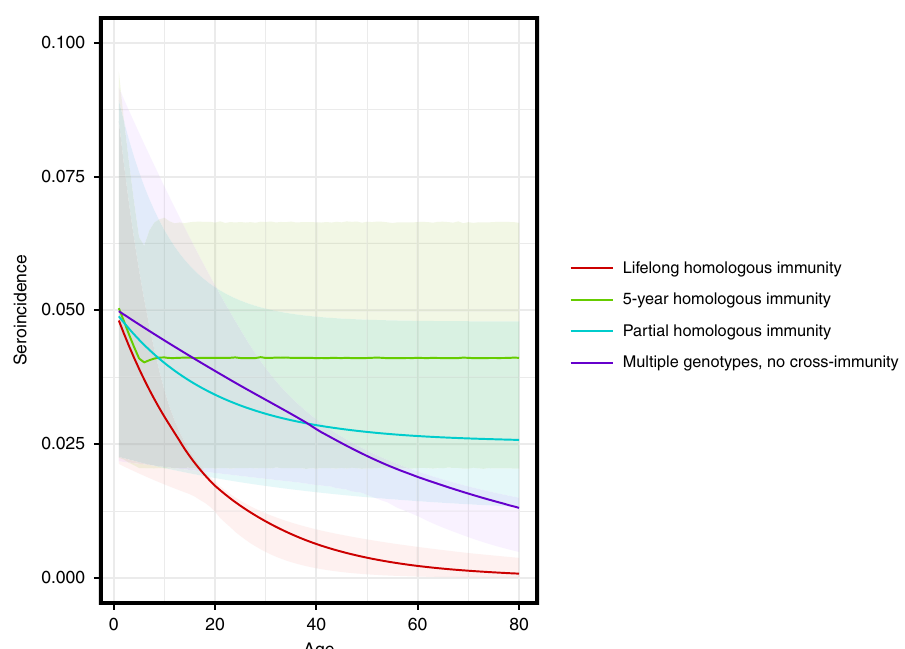
Fig. 7 Age-seroincidence curves under four models of coronavirus immunity. Each curve displays the age seroincidence for a single endemic strain. The four hypothetical models of coronavirus immunity are (1) infection grants lifelong, complete homologous immunity (red), (2) infection grants complete homologous immunity for 5 years, then reversion to complete susceptibility (green), (3) infection grants lifelong homologous immunity at 50% ef fi cacy (cyan), and (4) the strain consists of four antigenically diverse genotypes, each granting complete homologous immunity within genotype, but no cross- protection between genotypes (blue). Con fi dence bands represent uncertainty in the force of infection as estimated from the seroprevalence